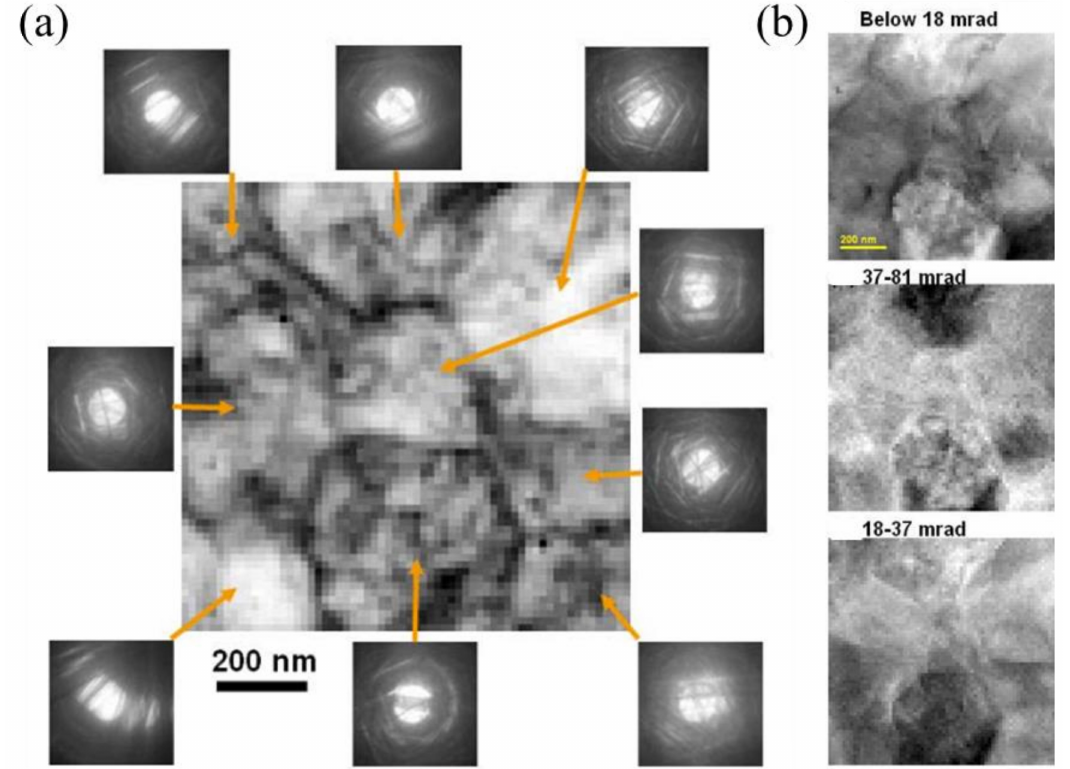
Figure 21. ( a ) Grain map from a Y-doped ZrO 2 thin-specimen. ( b ) Series of STEM images, reconstructed by selecting the following angles from the STEM dataset in a. below 18 mrad, 37–81 mrad and 18–37 mrad [176]. Figure 21 reprinted by permission from Cambridge University Press, Development of Diffraction Imaging for Orientation Analysis of Grains in Scanning Transmission Electron Microscopy, M Watanabe and D Williams, Copyright ©